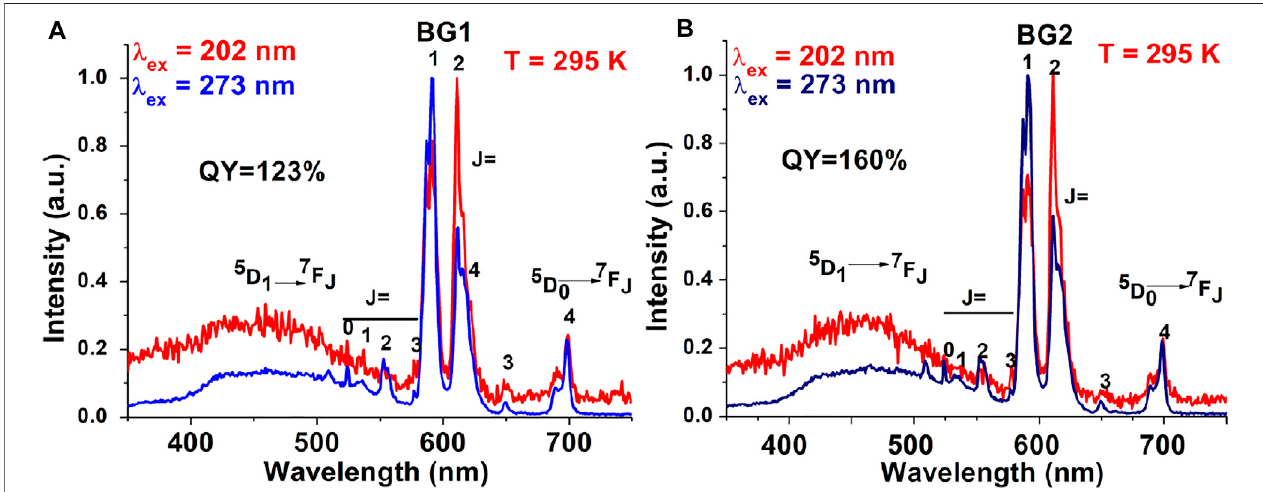
FIGURE 9 | Emission spectra recorded at RT for the as-prepared BaGdF 5 :Eu 3+ NPs synthesized in the absence (A) and presence (B) of IL (Chouryal et al., 2021).